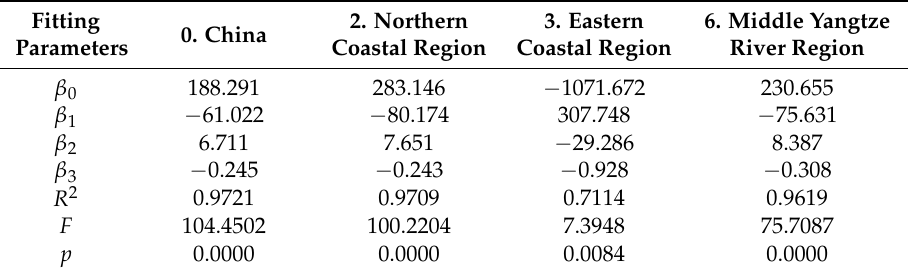
Table 4. EKC (Environmental Kuznets Curve) fitting parameters of China, northern coastal, eastern coastal and middle Yangtze River